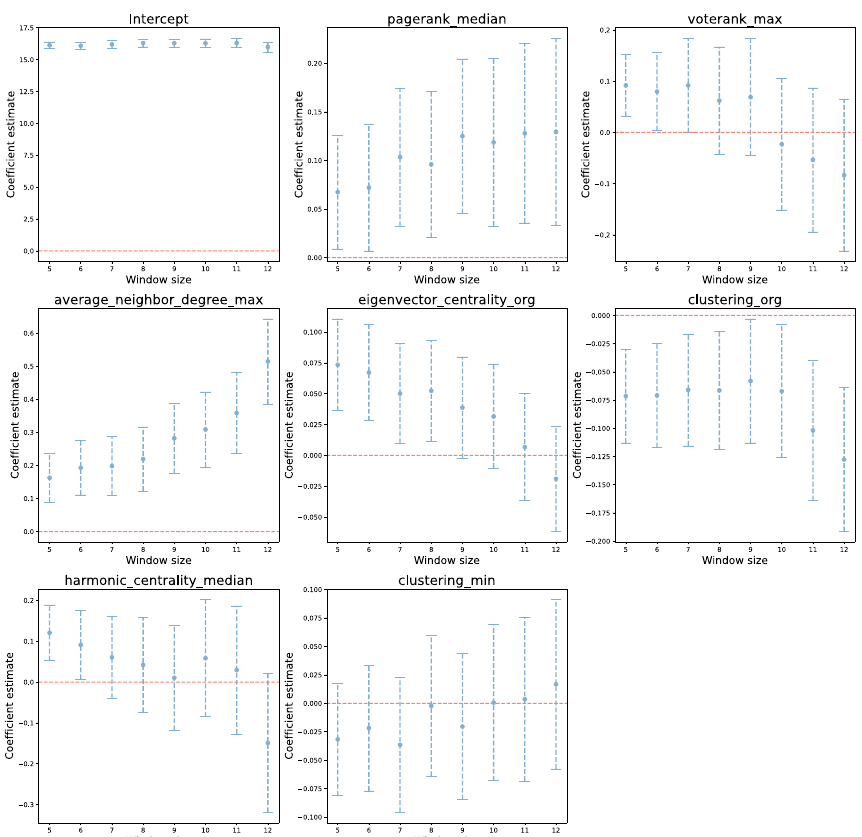
Fig. 8 Stability analysis under window size changes; linear regression. Blue dots represent coefficient estimates for each window size, with ± 1.96 × SE bands (dashed blue vertical lines). Horizontal red dashed lines mark 0. The number of firms included in the fits decreases as the window size increases, possibly introducing a selection bias